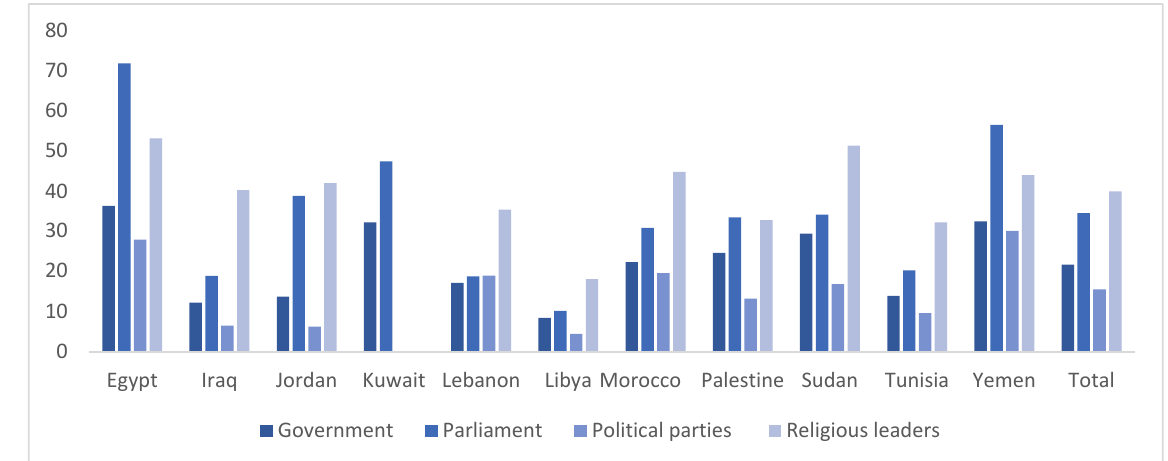
Figure 5. Percentage of people trusting government, parliament, political parties and religious leaders.Source: Arab